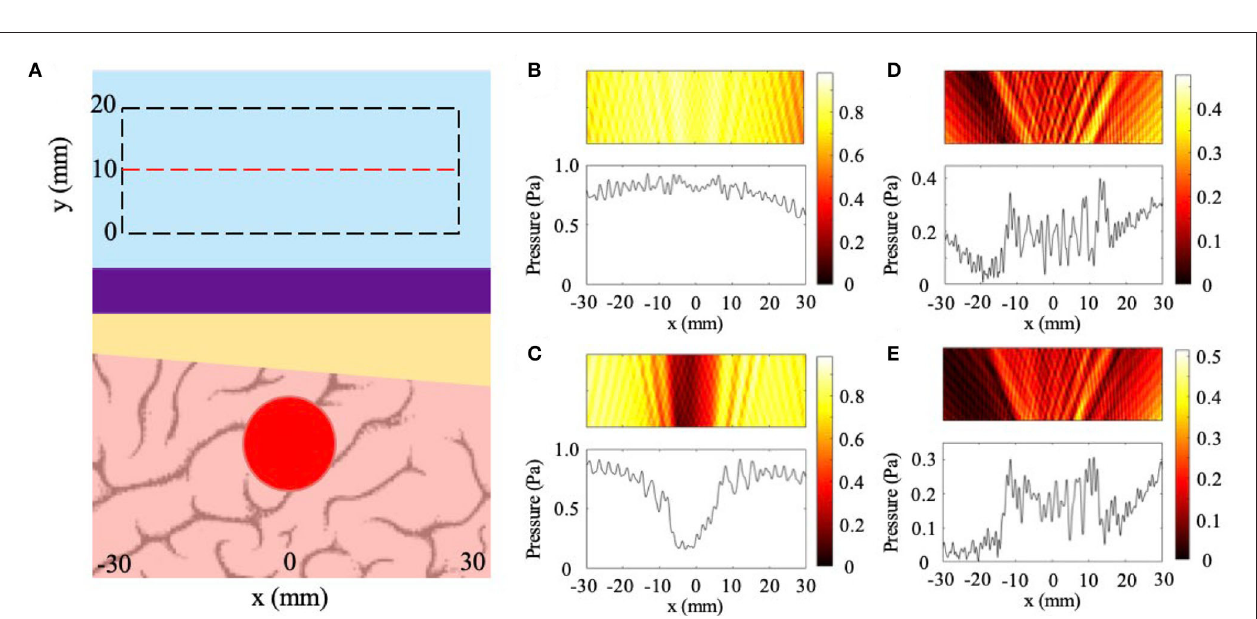
FIGURE 2 | Method to retrieve tumor scattering from the total pressure field. (A) Diagram of tumor-skull-NHCMM with incident pressure (green arrows). (B) Incident and reflected acoustic pressure field of an imaging plane wave incident on a concentric NHCMM-skull bilayer with a skull radius of 100mm. (C) Incident and reflected acoustic pressure field of the same geometry in (B) but with a brain tumor. (D) The subtraction of the measured pressure fields in (B,C) . (E) Filtering the results in (D) using a 2D Fourier transform to isolate the backscattering from just the tumor. The colorbar represents the normalized pressure amplitude.